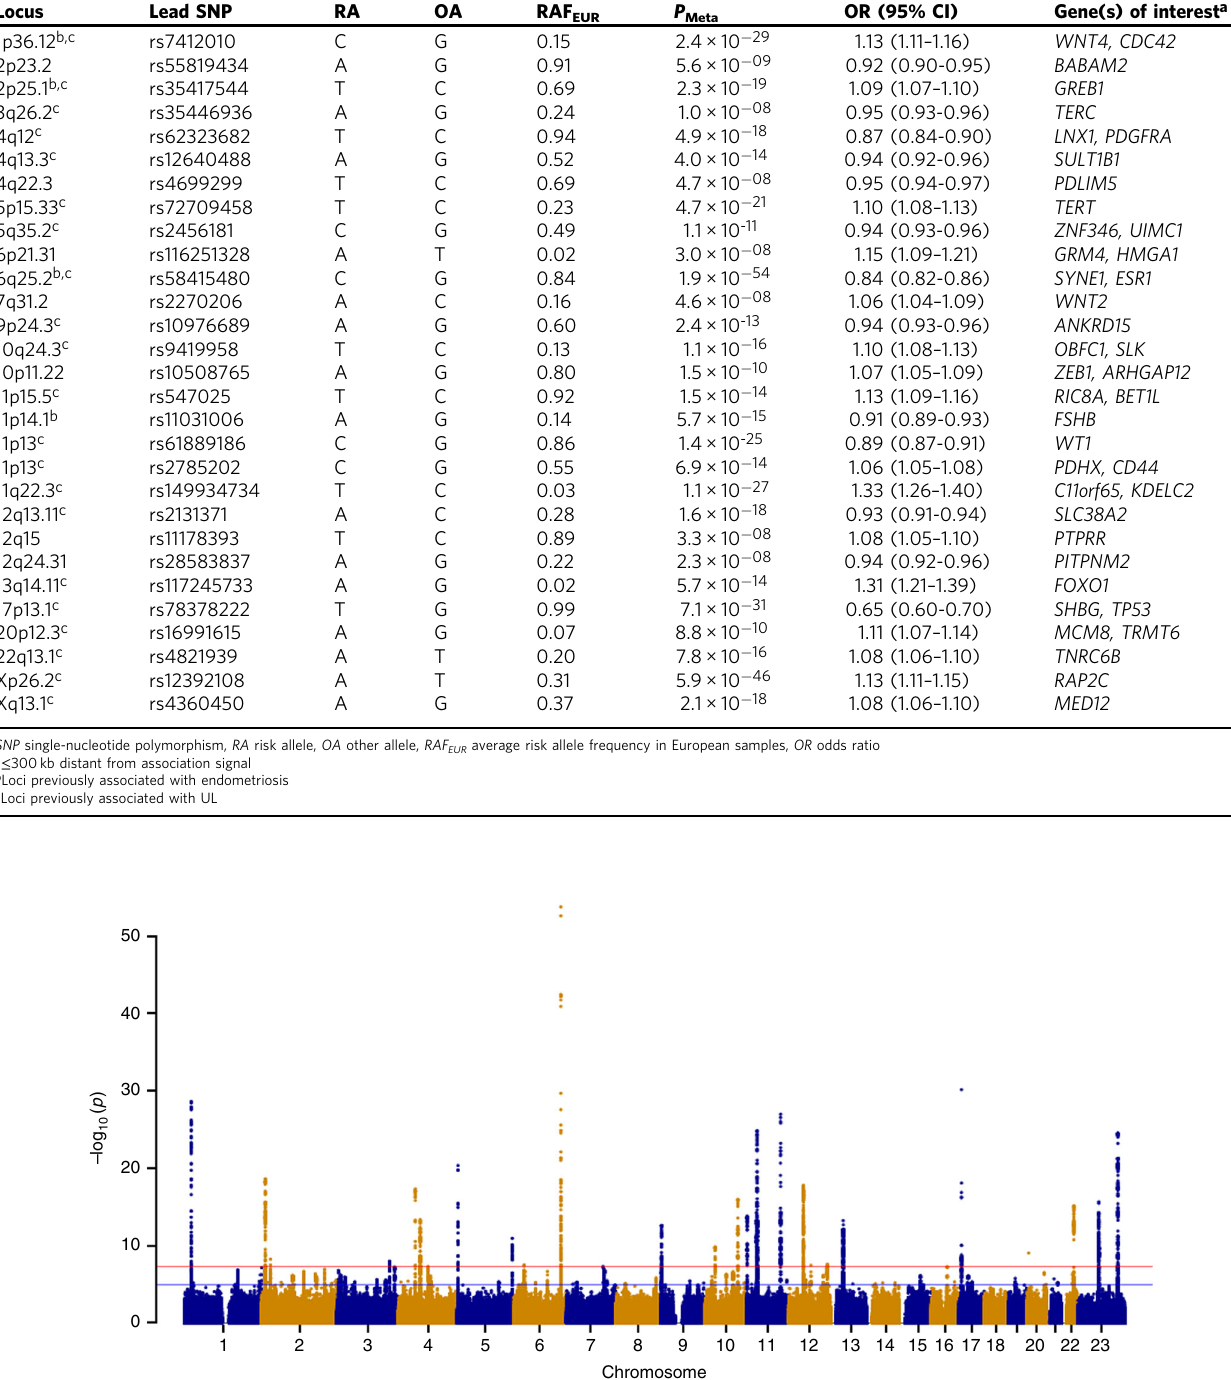
Fig. 1 Manhattan plot for UL GWAS meta-analysis across all cohorts. Meta-analysis of GWAS including 302,979 women of white European ancestry across all cohorts identi fi ed 29 independent loci associated with UL. Red and blue horizontal lines indicate genome-wide signi fi cant ( P < 5 × 10 − 8 ) and suggestive ( P < 1 × 10 − 5 ) thresholds,